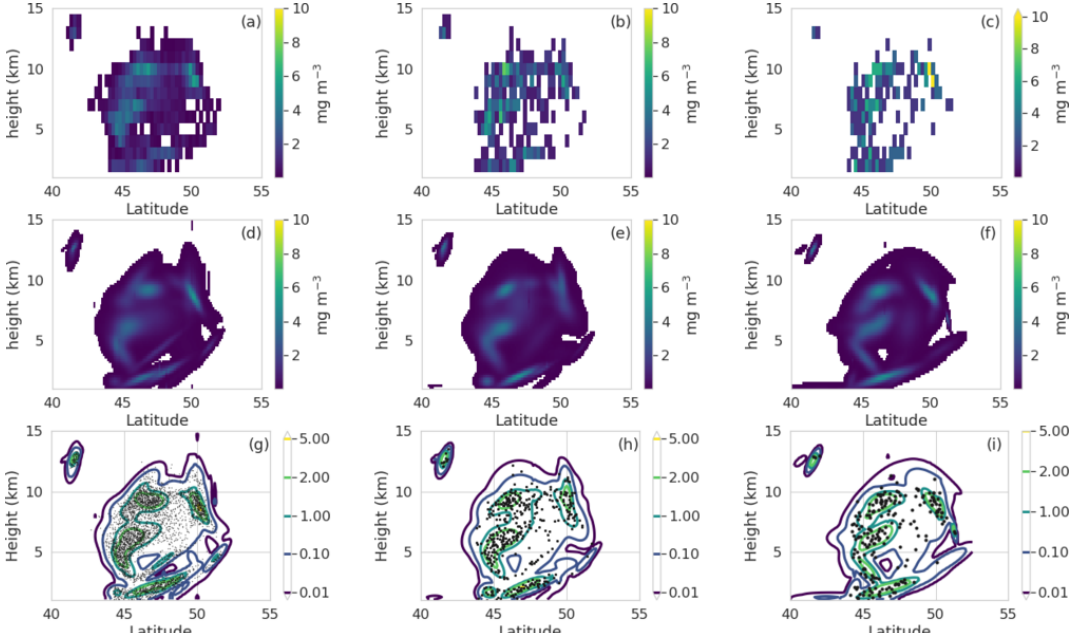
Figure 5. Concentrations at longitude-151. Top row ( a – c ) concentrations calculated using histogram method resolution 0.25 ◦ × 0.25 ◦ × 1000 m. Second row ( d – f ) and third ( g – i ) row concentrations calculated using GMM with 50 Gaussians and plotted at resolution of 0.1 ◦ × 0.1 ◦ × 200 m. For the second row concentrations below below 0.01 g m − 3 are not shown. The third row shows contour levels of output shown in second row and the black dots indicate position of computational particles within 0.125 ◦ of the − 151 line of longitude. The dots are shown smaller in ( g ) for clarity. First column ( a , d , g ) Run KA, second column ( b , e , h ) Run KB and third column ( c , f , i ) run